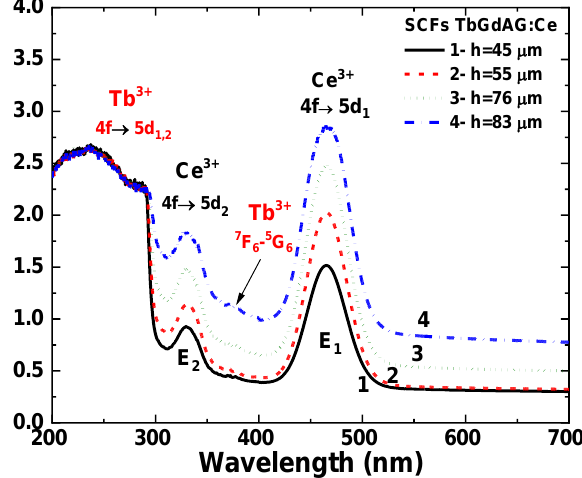
Figure 3. RT absorption spectra of TbGdAG:Ce SCF/YAG SC converters with different SCF thick- nesses.